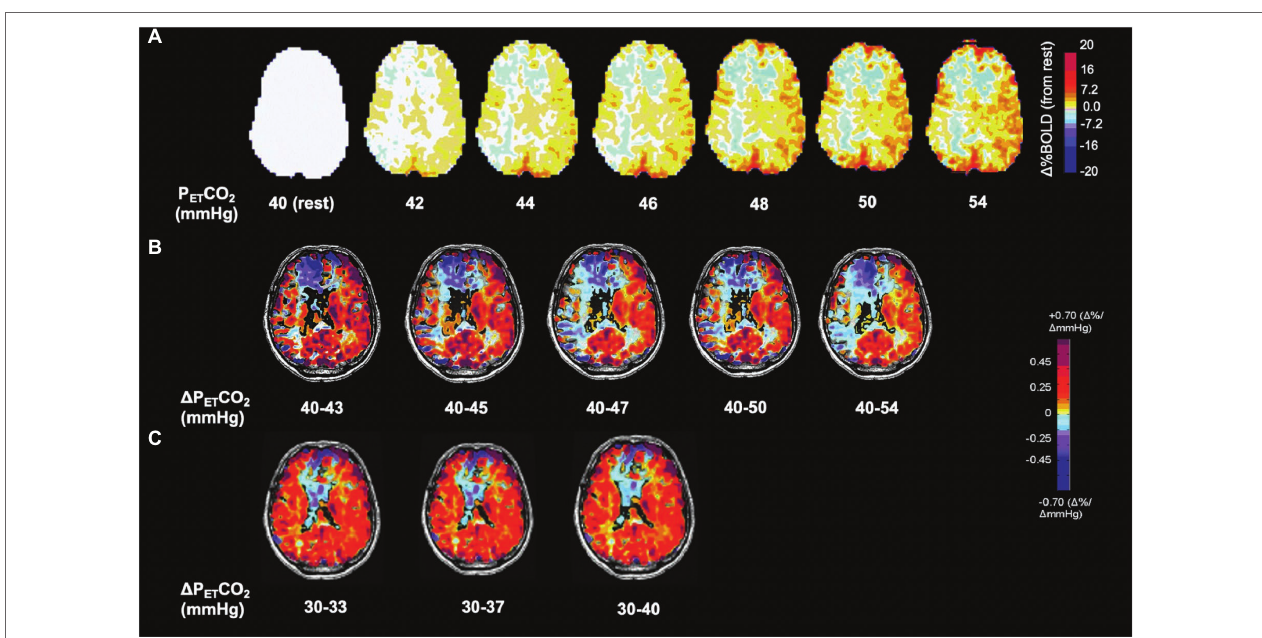
FIGURE 2 | Voxel-wise changes of BOLD signal and CVR as a function of Δ P ET CO 2 in the hypocapnic and hypercapnic range. Same subject as Figure 1 . (A) BOLD signal change in % from baseline P ET CO 2 40 mmHg shown in interval increases of 2 mmHg. Note progressive changes in BOLD signal at every increment of P ET CO 2 of 2 mmHg. (B) Effect of CVR calculated as Δ BOLD/ Δ P ET CO 2 on differences in Δ P ET CO 2 . Note increases in the extent of steal with greater changes in PaCO 2 demonstrating its shortcomings for normalization for Δ P ET CO 2 . Standardization therefore results from using a reproducible stimulus. (C) CVR in the hypocapnic range is radically different from the hypercapnic range (see also Figure 3 ). Respective color scales on